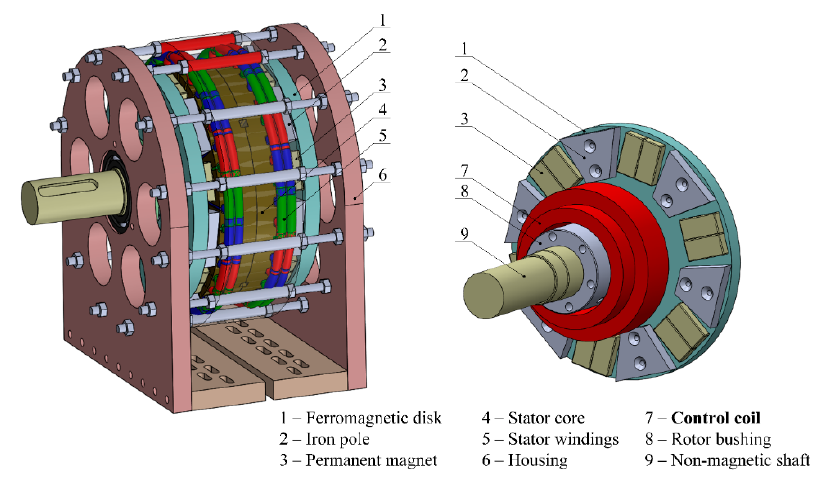
Figure 7. HEAFM construction [55].